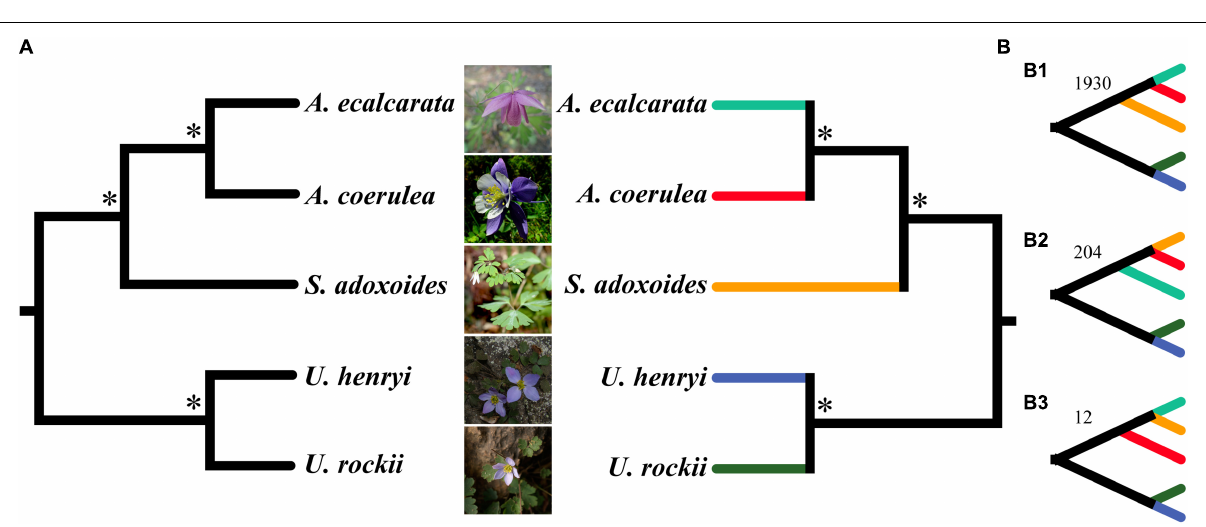
FIGURE 6 | The phylogenetic analysis using concatenate (A) and coalescent method (B) based on single-copy genes. Asterisk ( ∗ ) above the branches in left (A) concatenate tree indicate the maximum support values and posterior probabilities in ML and BI analyses. ∗ Above branches in right (B) coalescent tree are support values of MP-EST and STAR with bootstrapping analyses and local posterior probabilities. Panels (B1–B3) are the coalescent results with the 3 tree topologies and correspondent SCG